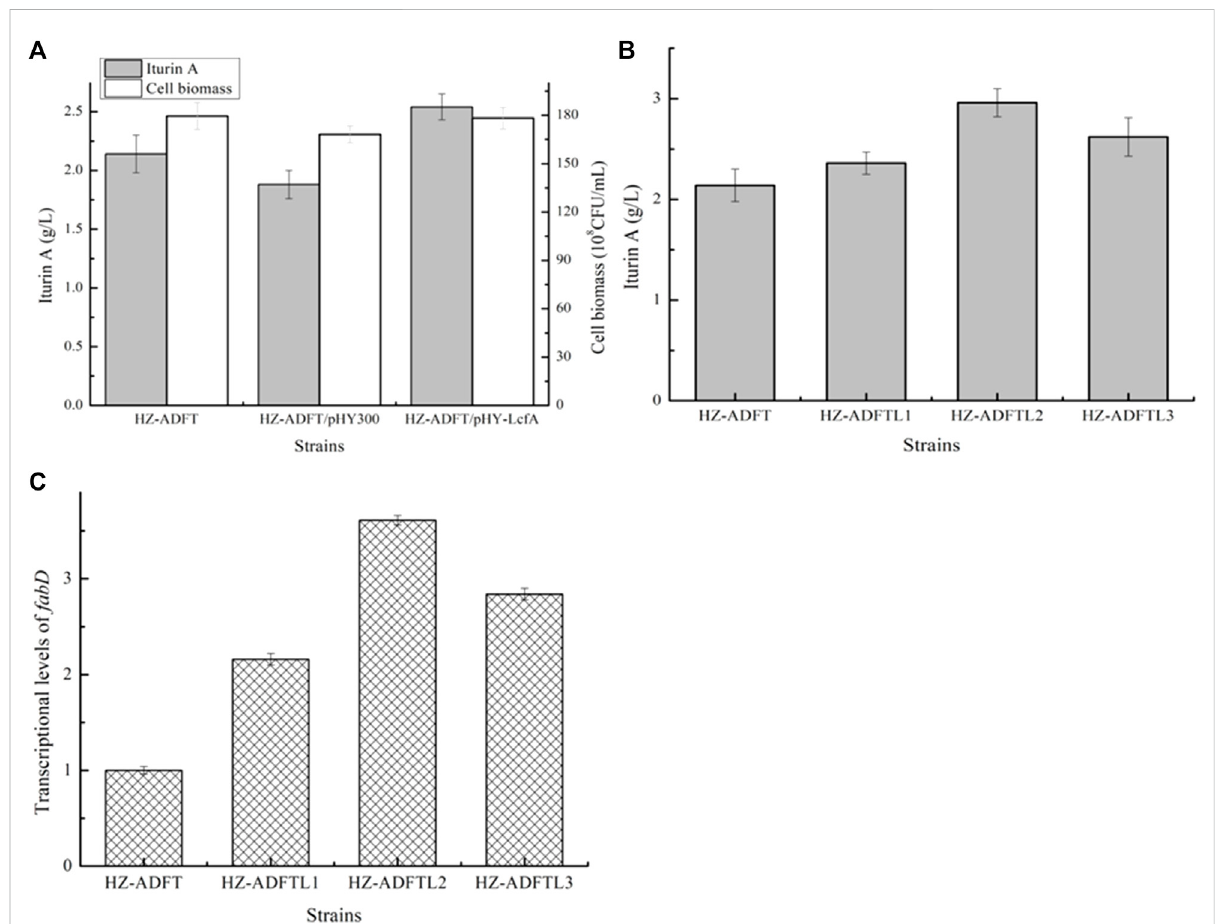
FIGURE 5 Effect of long-chain fatty acid-CoA ligase overexpression on iturin A production. (A) Effects of long-chain fatty acid-CoA ligase LcfA overexpression on iturin A production. (B) Iturin A yields of LcfA overexpression strains mediated by different promoters. (C) Transcriptional level